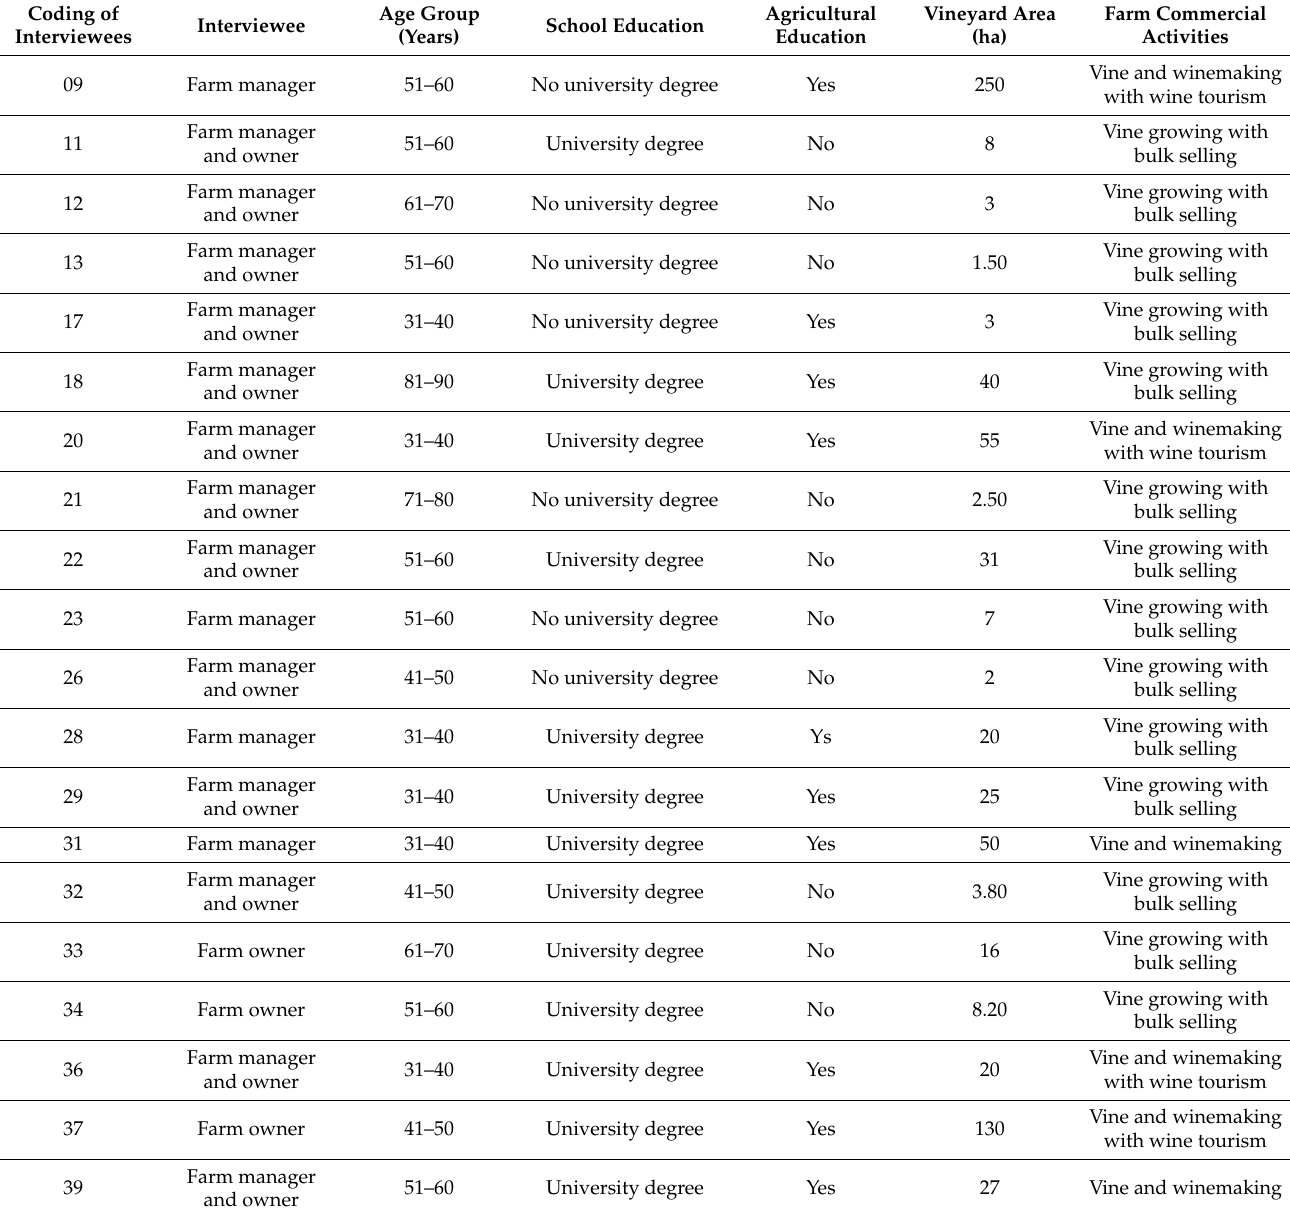
Table 2. Characterisation of the interviewees whose narratives were recorded and subject to treatment. Coding of